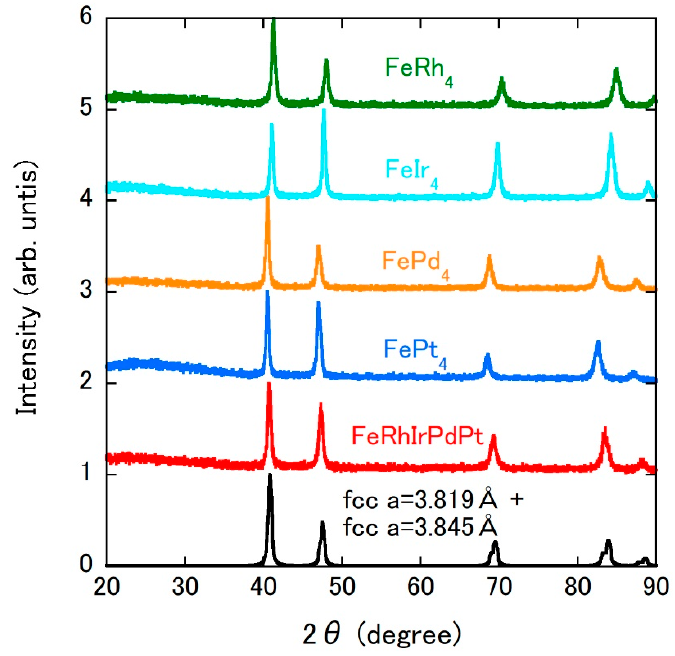
Figure 1. X-ray diffraction patterns of FeRh 4 , FeIr 4 , FePd 4 , FePt 4 , and FeRhIrPdPt. The simulated pattern for FeRhIrPdPt is also shown. The origin of each pattern is shifted by an integer value for clarity.